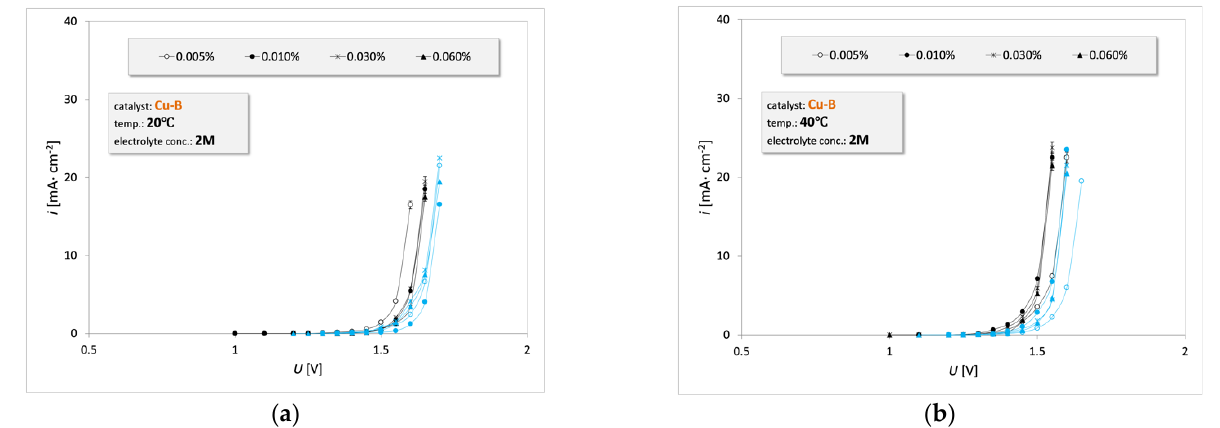
Figure 12. Electrooxidation curves of WEO emulsion (black lines) and detergent (blue lines) for various concentrations of detergent and emulsion on the Cu-B catalyst for an electrolyte concentration of 2 M. Electrooxidation: ( a ) temperature: 20 °C; ( b ) temperature: 40 °C.